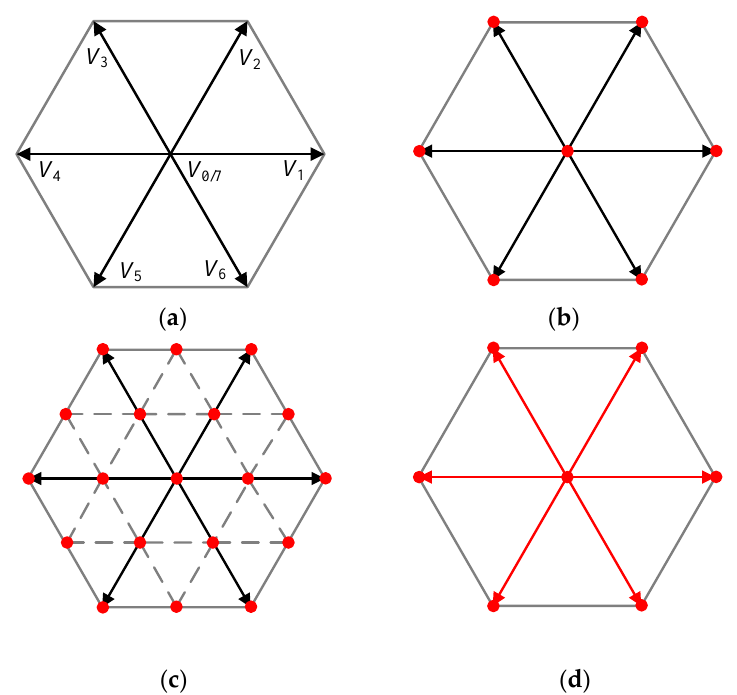
Figure 2. Feasible voltage vectors and active voltage vector region (AV 2 R) of existing model predictive control (MPC) methods: ( a ) Feasible voltage vectors; ( b ) AV 2 R of MPC1; ( c ) AV 2 R of MPC2; ( d ) AV 2 R of MPC3.